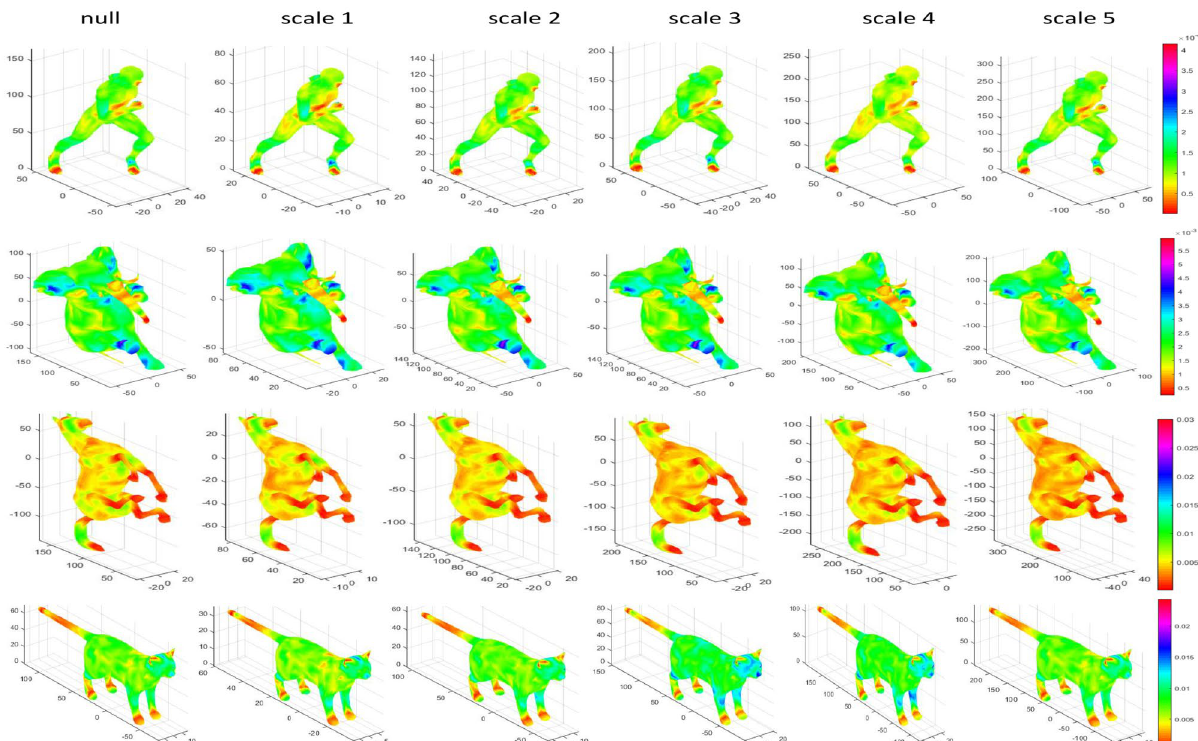
Figure 6. Robustness of SIMHW to scale transformation based on the SHREC2010